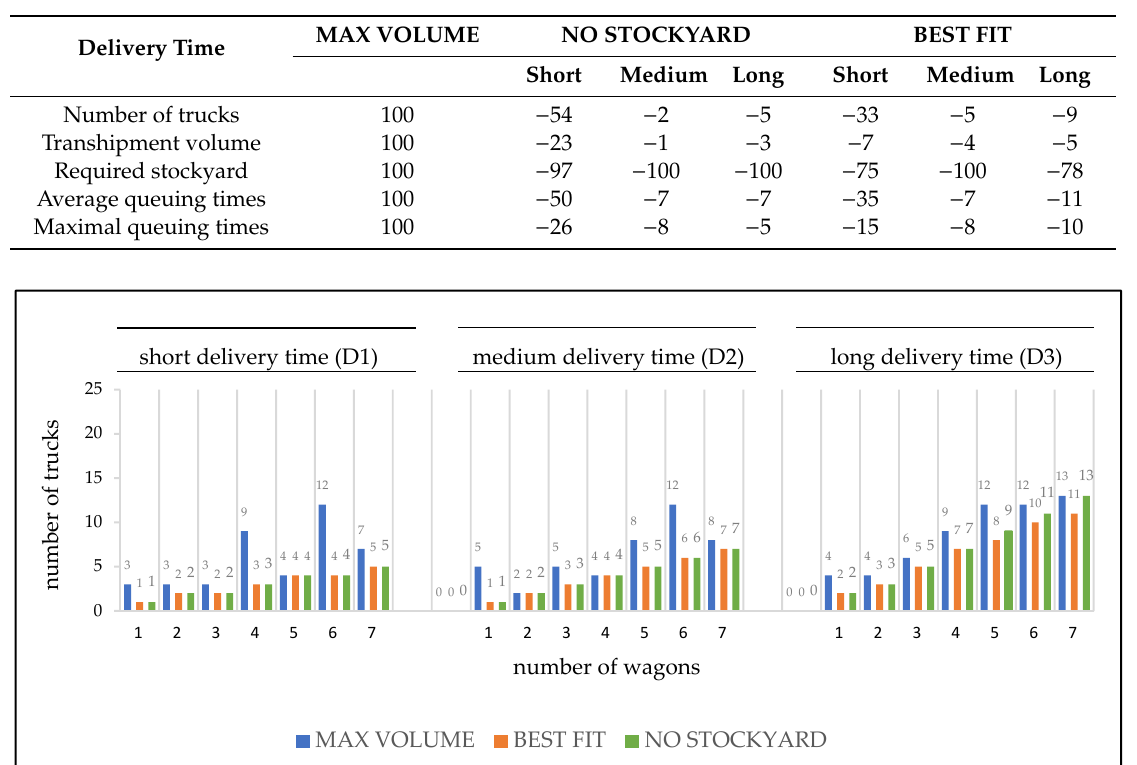
Table 11. Strategy comparison for two train pick-ups (in %).